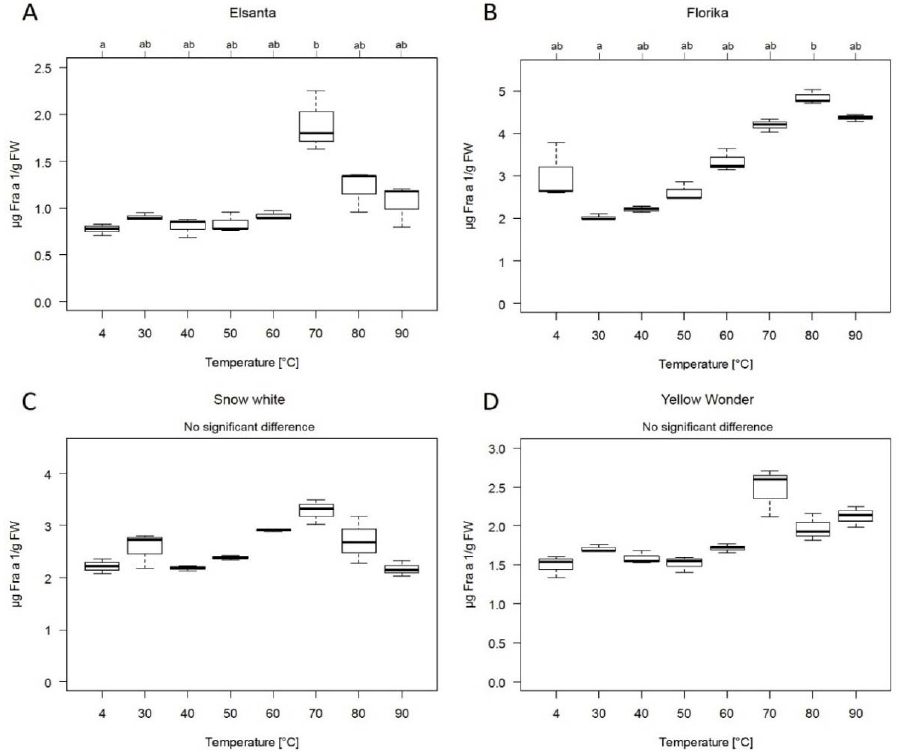
Figure 4. Thermal stability of native Fra a 1. Allergen content of strawberry cultivar ( A ) Elsanta, ( B ) Florika, ( C ) Snow White and ( D ) Yellow Wonder in µg Fra a 1/g FW. Strawberry extracts were heated for 10 min at increasing temperatures from 30 to 90 ◦ C. Untreated extract served as control (4 ◦ C). Fra a 1 content was determined with indirect competitive ELISA. Comparisons of median values were performed by the Dunn’s Test. Significant differences for each group were calculated at a significance level of 5% ( p value ≤ 0.05) indicated with letters a and